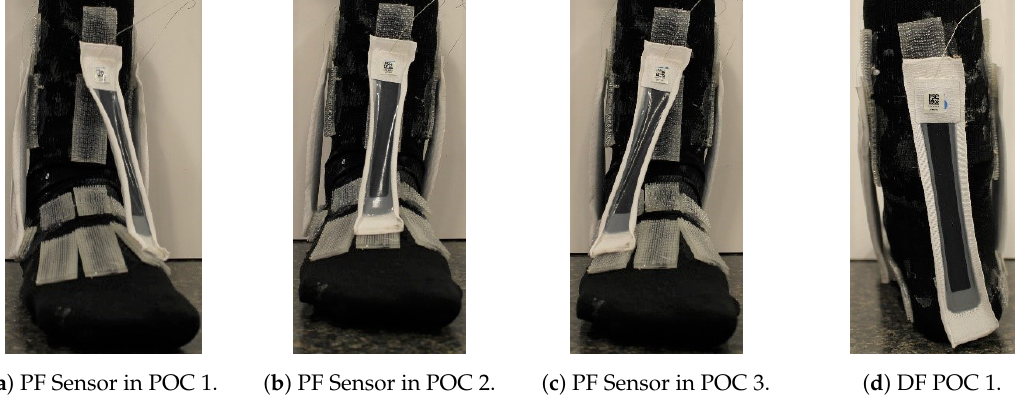
Figure 3. PF and DF sensor POC positions: ( a ) POC 1; ( b ) POC 2; ( c ) POC 3; and ( d ) The DF sensor was positioned the same for all three POCs (heel of the foot is